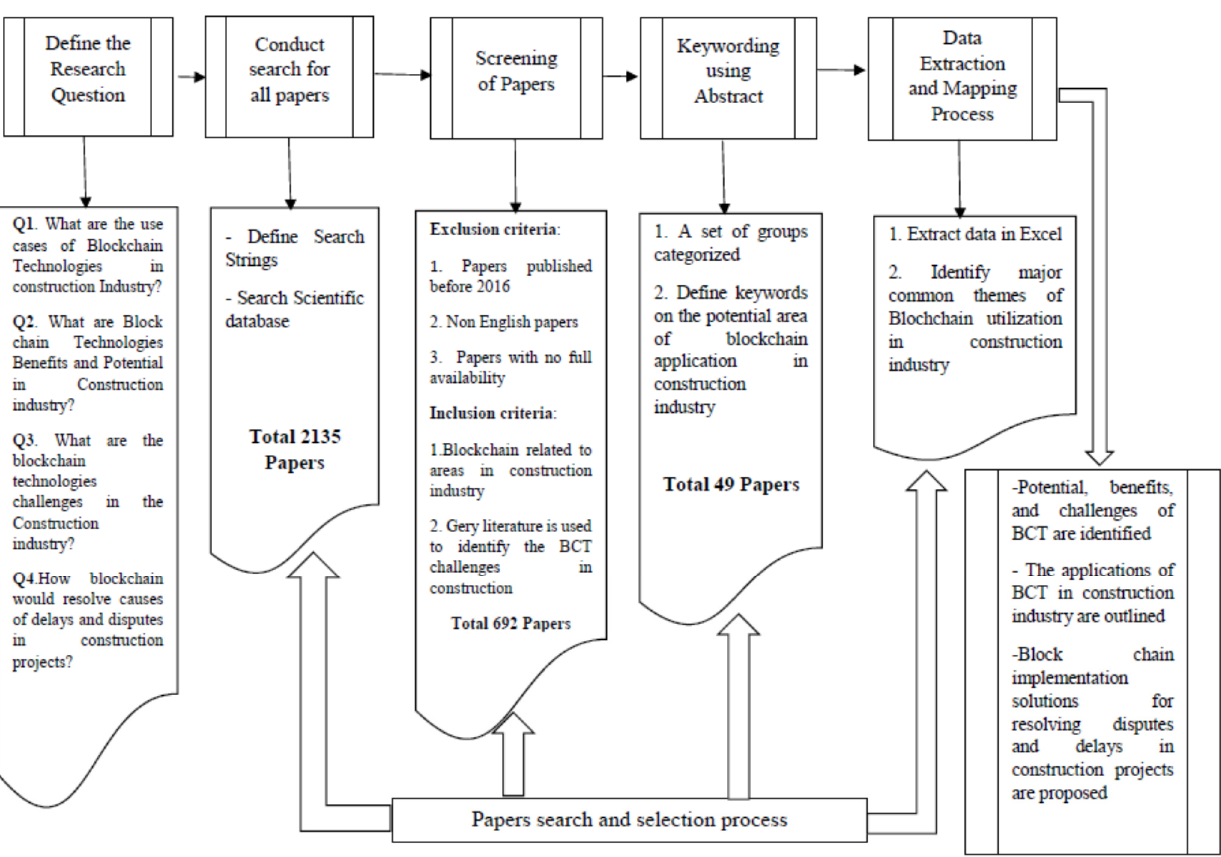
Figure 2. Systematic mapping flow.